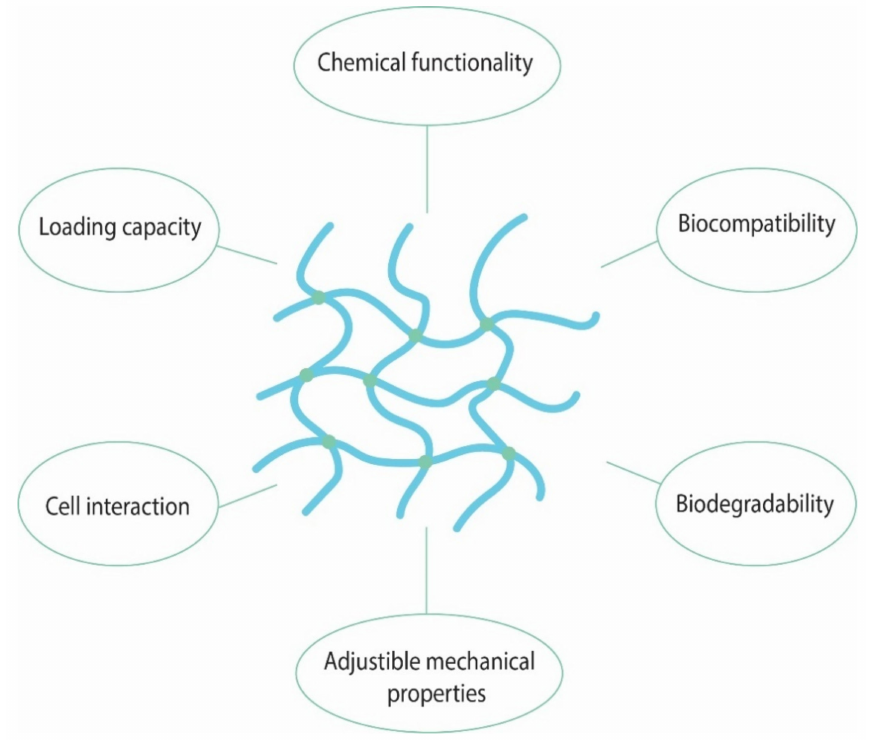
Figure 5. The main characteristics of hydrogels with medical